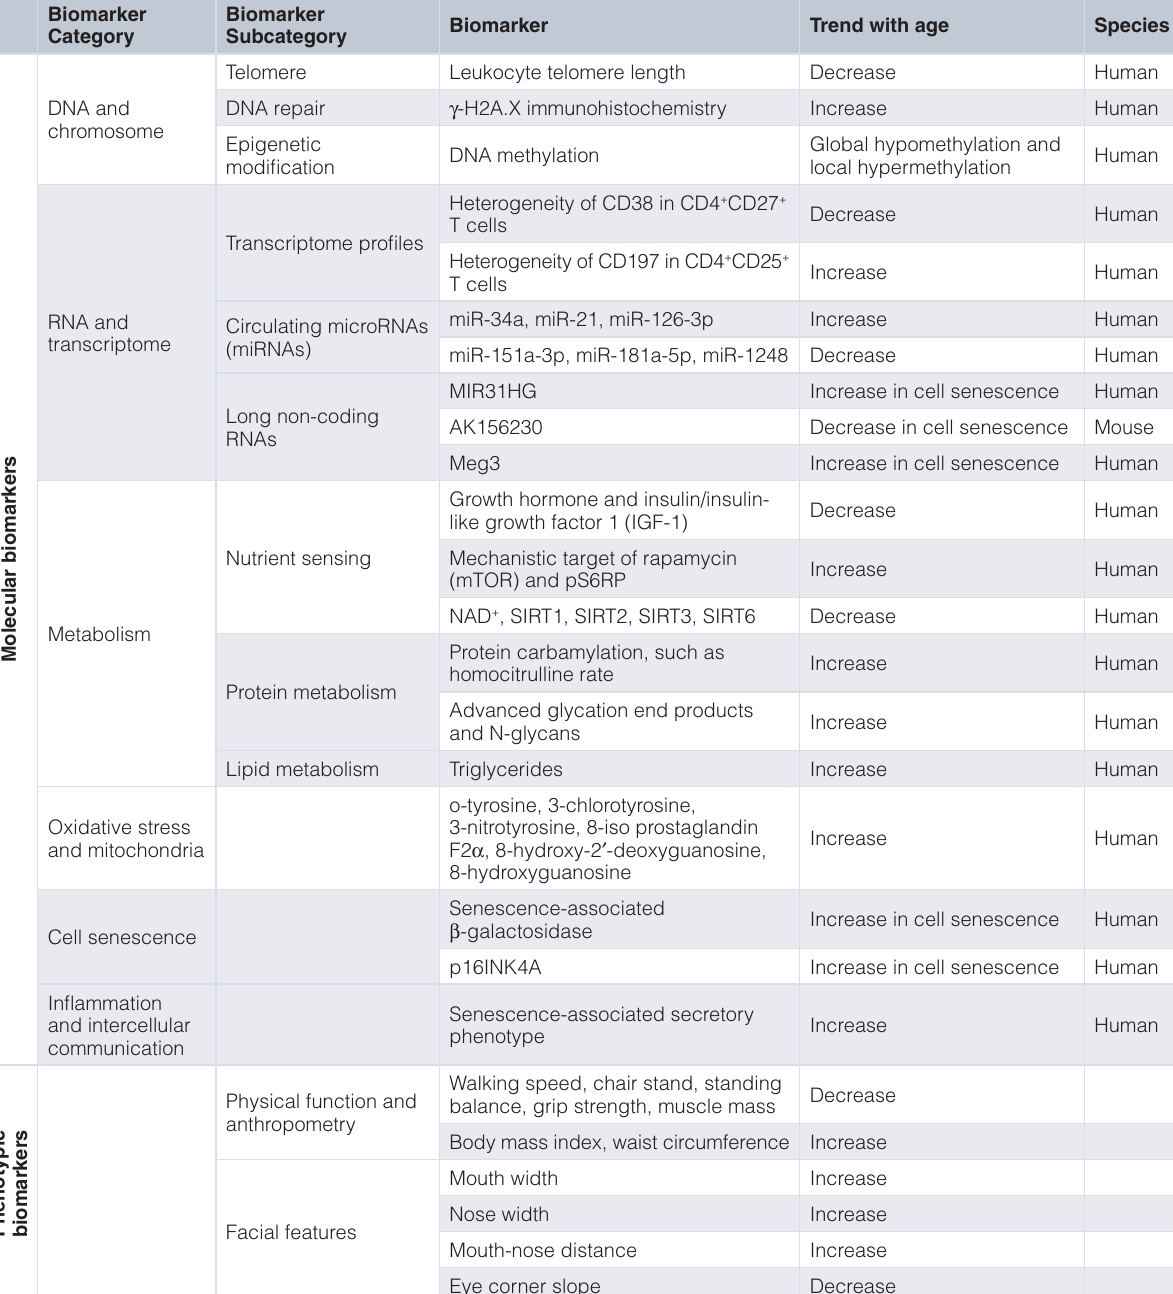
Table 1. Biomarkers of aging. For species source, if there is one in humans, then other model organisms are